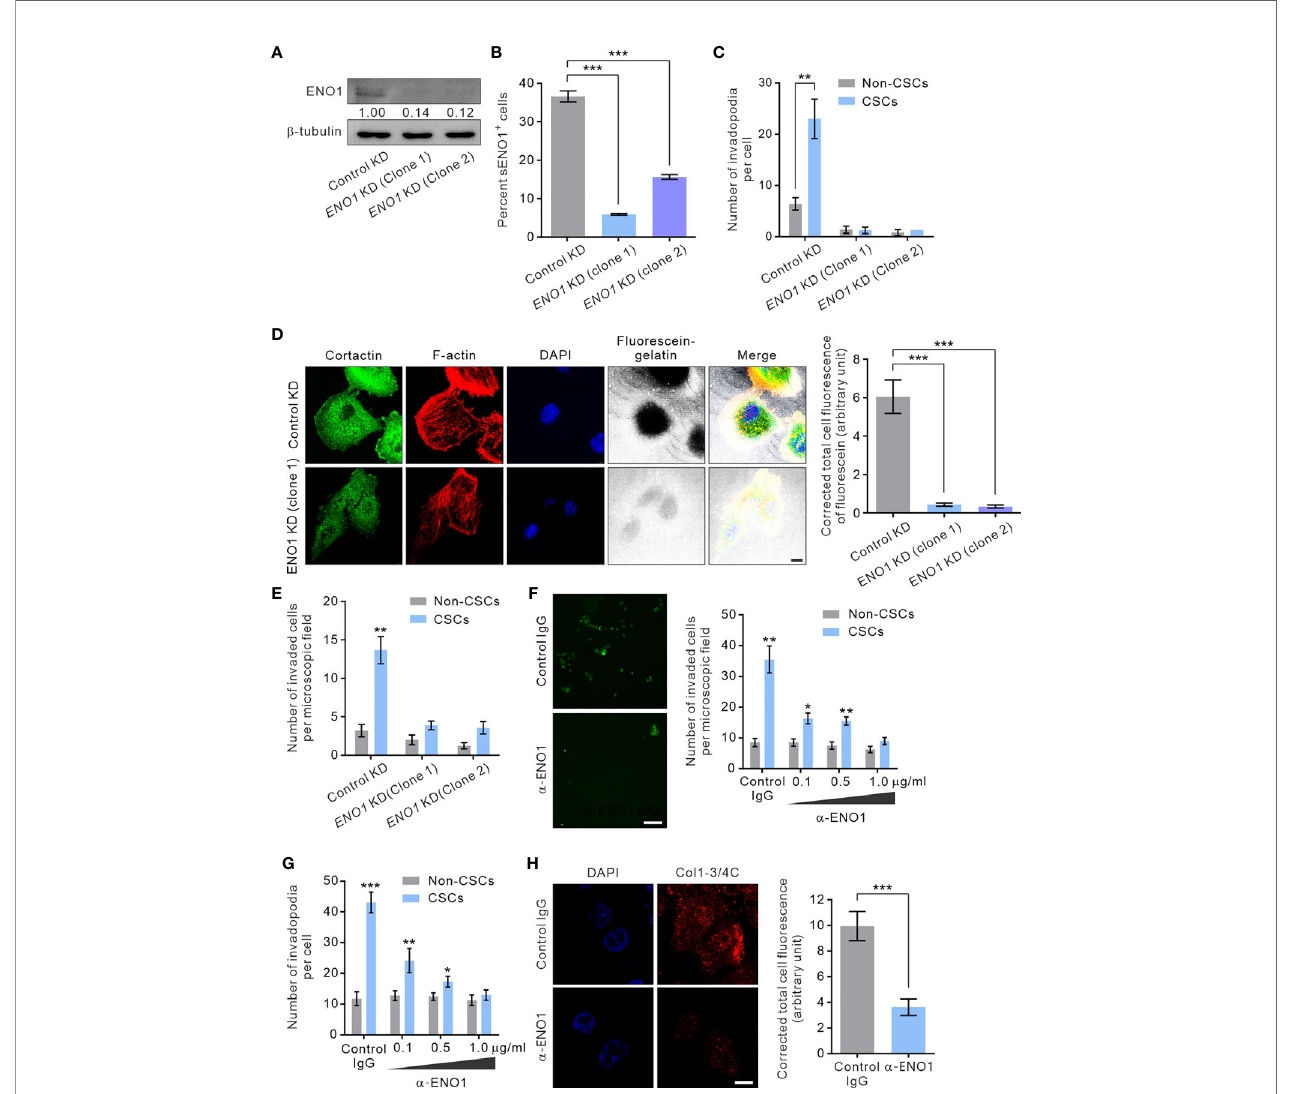
FIGURE 6 | sENO1 contributes to the invadopodial formation and the matrix-degradative function of CSCs. (A) Immunoblotting analysis showing the effect of lentivirus shRNA-mediated knockdown (KD) of ENO1 expression in PC-3 cells. Protein levels were quanti fi ed by densitometric analysis of the bands, normalized to b - tubulin (loading control). (B) Bar graph showing the percentage of sENO1 + PC-3 cells with KD of ENO1 expression or control KD. (C) Bar graph showing the density of invadopodia (represented by cortactin + F-actin + puncta) per cells in PC-3 CSCs (represented by CD44 + CD133 + cells) or non-CSCs (represented by cells in other subpopulations) with ENO1 KD or control KD. Error bars represent mean ± SEM from three independent experiments (n = 3). Unpaired t-test was performed where **p < 0.01, ***p < 0.001 in (B, C) . (D) PC-3 cells with KD of ENO1 expression or the control KD cells were seeded on top of a fl uorescein-conjugated gelatin matrix and immunostained with cortactin (green) or phalloidin (F-actin; red). Nuclei were counterstained with DAPI (blue). Right, the fl uorescence intensity of fl uorescein- conjugated gelatin within the boundary (determined by F-actin staining) of PC-3 cells with ENO1 KD or control KD (n = 50 cells counted per sample). Unpaired t-test was performed where ***p < 0.001. (E) Bar graph showing the invasive capacity of PC-3 CSCs with ENO1 KD or control KD in a dual-chamber invasion assay. Error bars represent mean ± SEM from three independent experiments (n = 3). Unpaired t-test was performed where **p < 0.01 versus non-CSCs. (F) Representative immuno fl uorescence images of CD44 + CD133 + PC-3 cells (representing CSCs) that had invaded the type I collagen matrix in the presence of an increasing concentration (0.1-1.0 µg/ml) of the anti-ENO1 polyclonal antibody (pAb; a -ENO1) in a dual-chamber invasion assay. The nuclei of the invaded cells were stained with SYTOX-green. Scale bars, 500 µm. Right, the number of invaded cells. Cells in other subpopulations (representing non-CSCs) were included as a control. Error bars represent mean ± SEM from three independent experiments (n = 3). Unpaired t-test was performed throughout where *p < 0.05, **p < 0.01 versus non-CSCs. (G) The invadopodia density per cell in PC-3 CSCs or non-CSCs exposed to an increasing concentration of a -ENO1. Error bars represent mean ± SEM from three independent experiments (n = 50 cells counted per sample). Unpaired t-test was performed where *p < 0.05, **p < 0.01, ***p < 0.001 versus non-CSCs. (H) PC-3 CSCs were seeded on top of a gelatin matrix in the presence or absence of a -ENO1 (20 µg/ml). Shown are the extent of matrix degradation as re fl ected by immunostaining with anti-Col1-3/4C (red). Right, the total cell fl uorescence intensity of Col1-3/4C in PC-3 CSCs treated with a -ENO1 or a control IgG (n = 50 cells counted per sample). Unpaired t-test was performed where ***p <